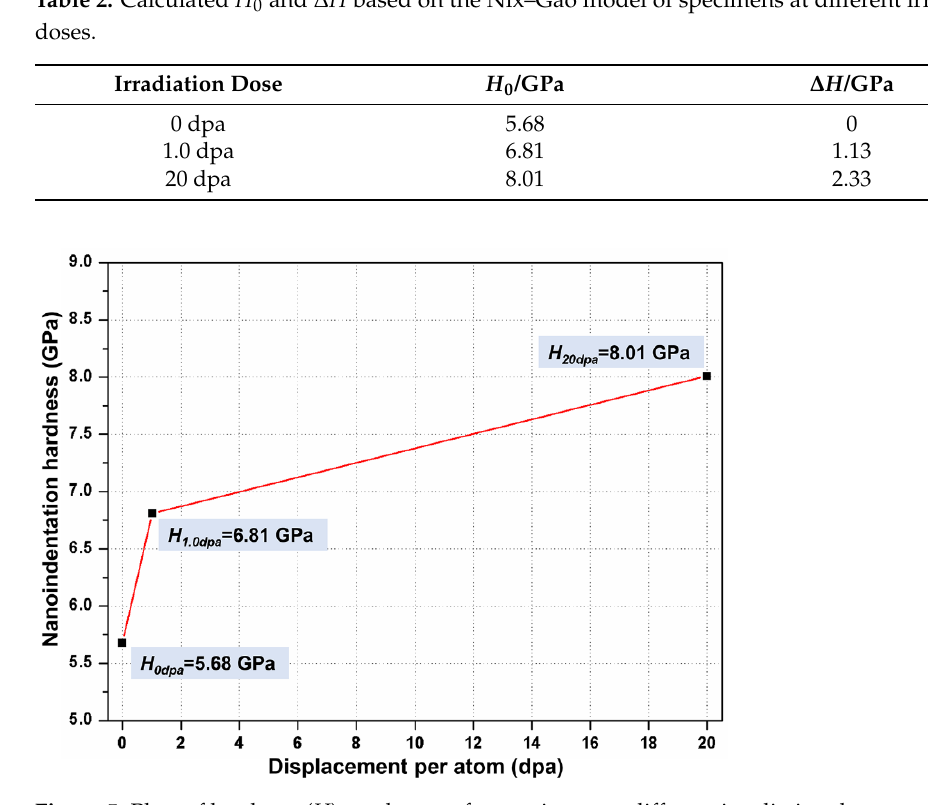
Figure 5. Plots of hardness ( H ) vs. damage for specimens at different irradiation